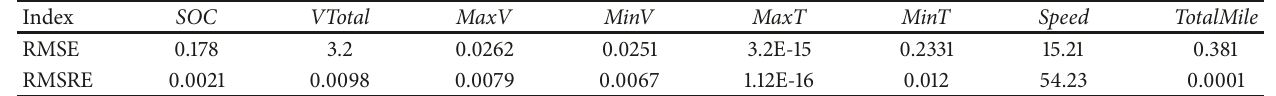
Table 2: Analysis of the performance index of interpolation.